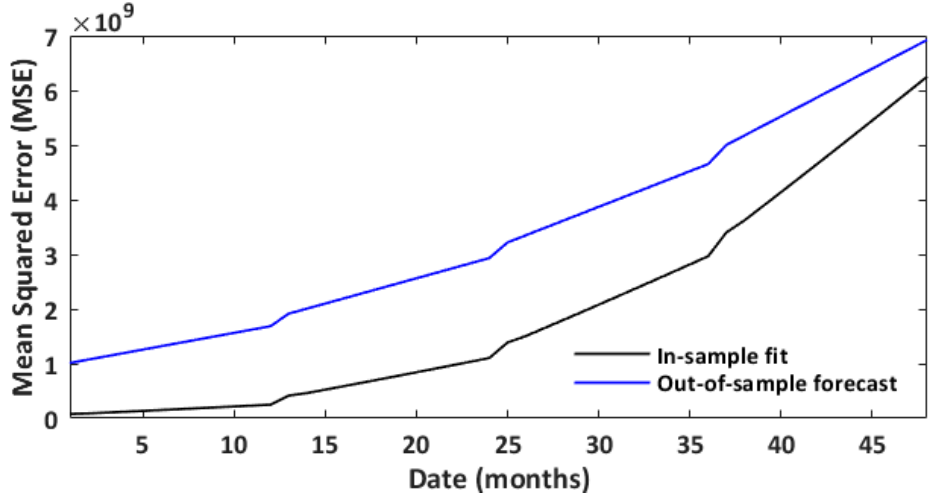
Figure 10. Comparison of Mean Squared Error (MSE) values for in-sample model fit and out-of-sample forecast.